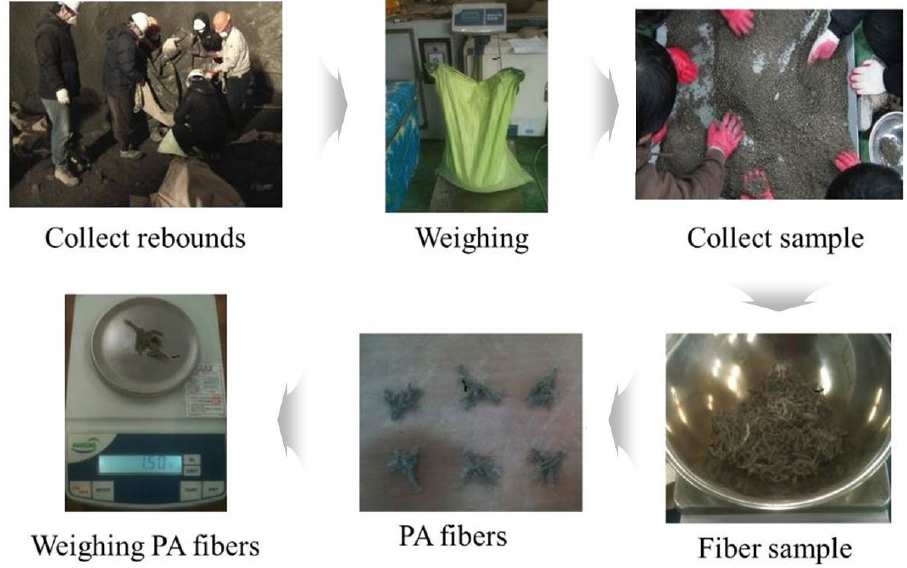
Figure 11. PA shotcrete rebounding test procedure. Table 10. PAFRS rebounding test results.